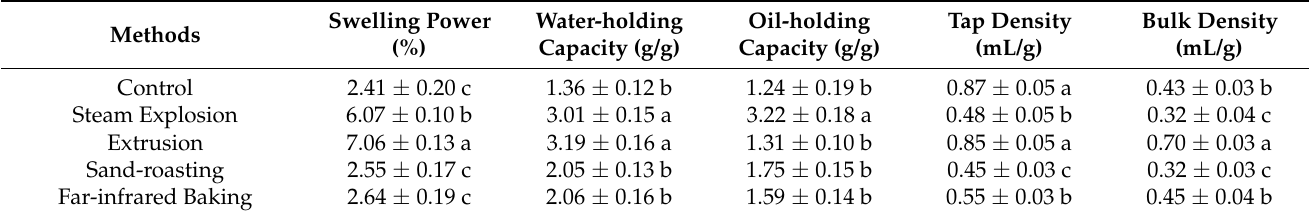
Table 3. Effect of thermal treatment on the functional properties of whole grain highland barley flour.